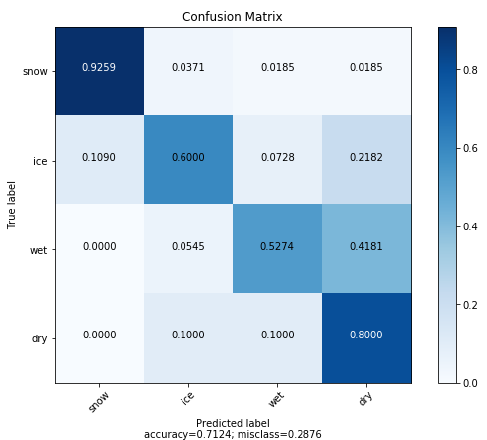
Figure 5. Confusion matrix generated for the test data using the SqueezeNet1_1 model.